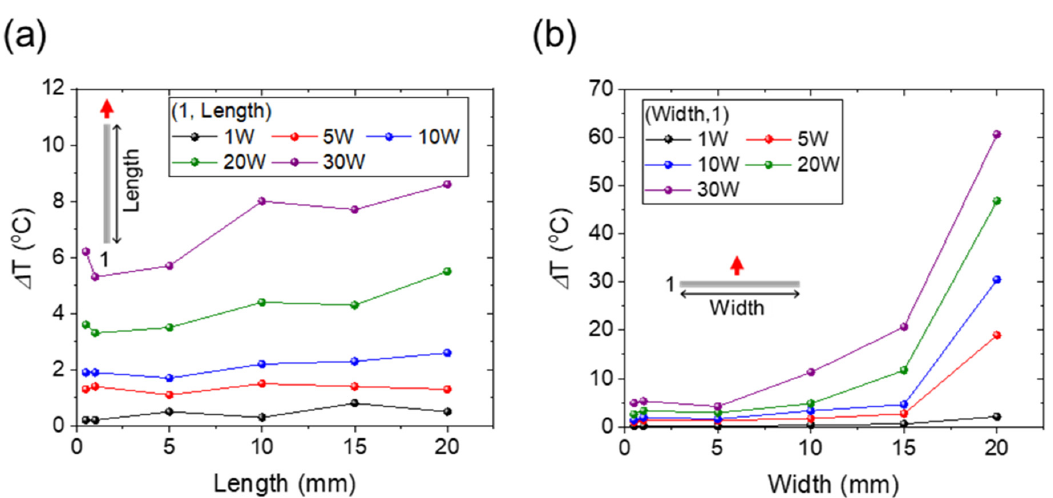
Figure 6. ( a ) △ T (1, 0.5) , △ T (1, 1) , △ T (1, 5) , △ T (1, 10) , △ T (1, 15) , △ T (1, 20) , ( b ) △ T (0.5, 1) , △ T (1, 1) , △ T (5, 1) , △ T (10, 1) , △ T (15, 1) , and △ T (20, 1) by MW irradiation at 1, 5, 10, 20, 30 W output powers for 30 s, respectively. Inset images are the sample shape. The red arrows of inset are the direction of conveying the samples.